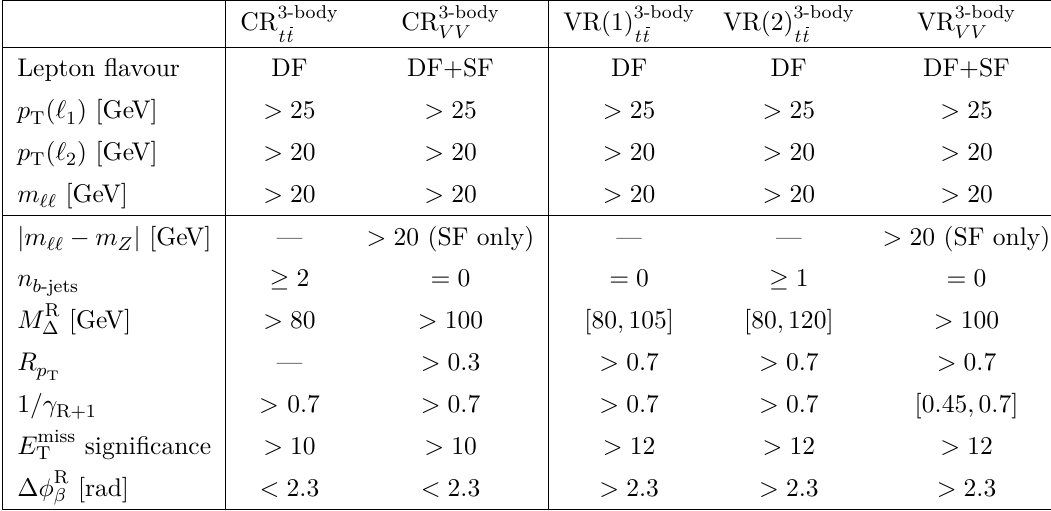
Table 8 . Three-body selection. Control and validation regions definitions. The common selection defined in section 5 also applies to all regions. A further control region CR in table 7.